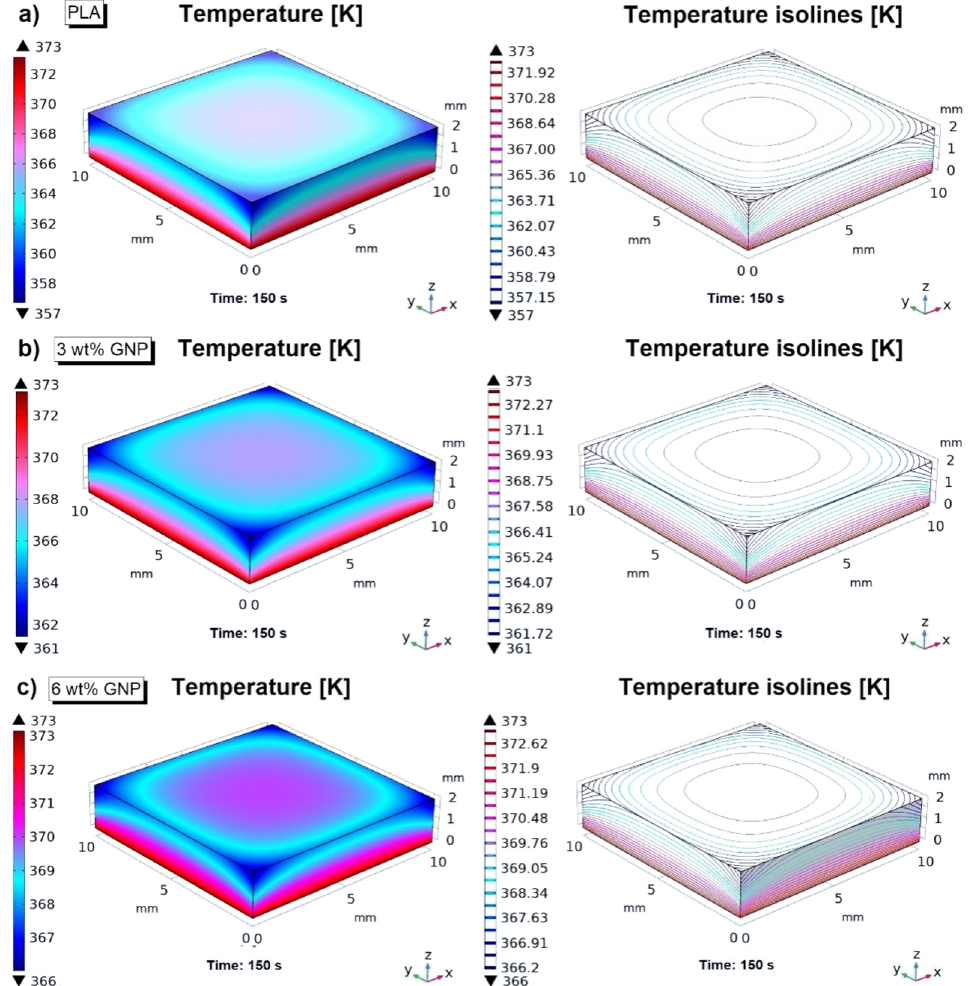
Figure 9. Numerical prediction of the average surface temperature profiles ( left side ) and temperature isolines ( right side ) recorded at steady-state condition ( t = 150 s), and at temperature value of 373.15 K for heat sinks based on pure PLA, PLA reinforced with 3 wt% of GNPs and 6 wt% of GNPs in ( a – c ), respectively.